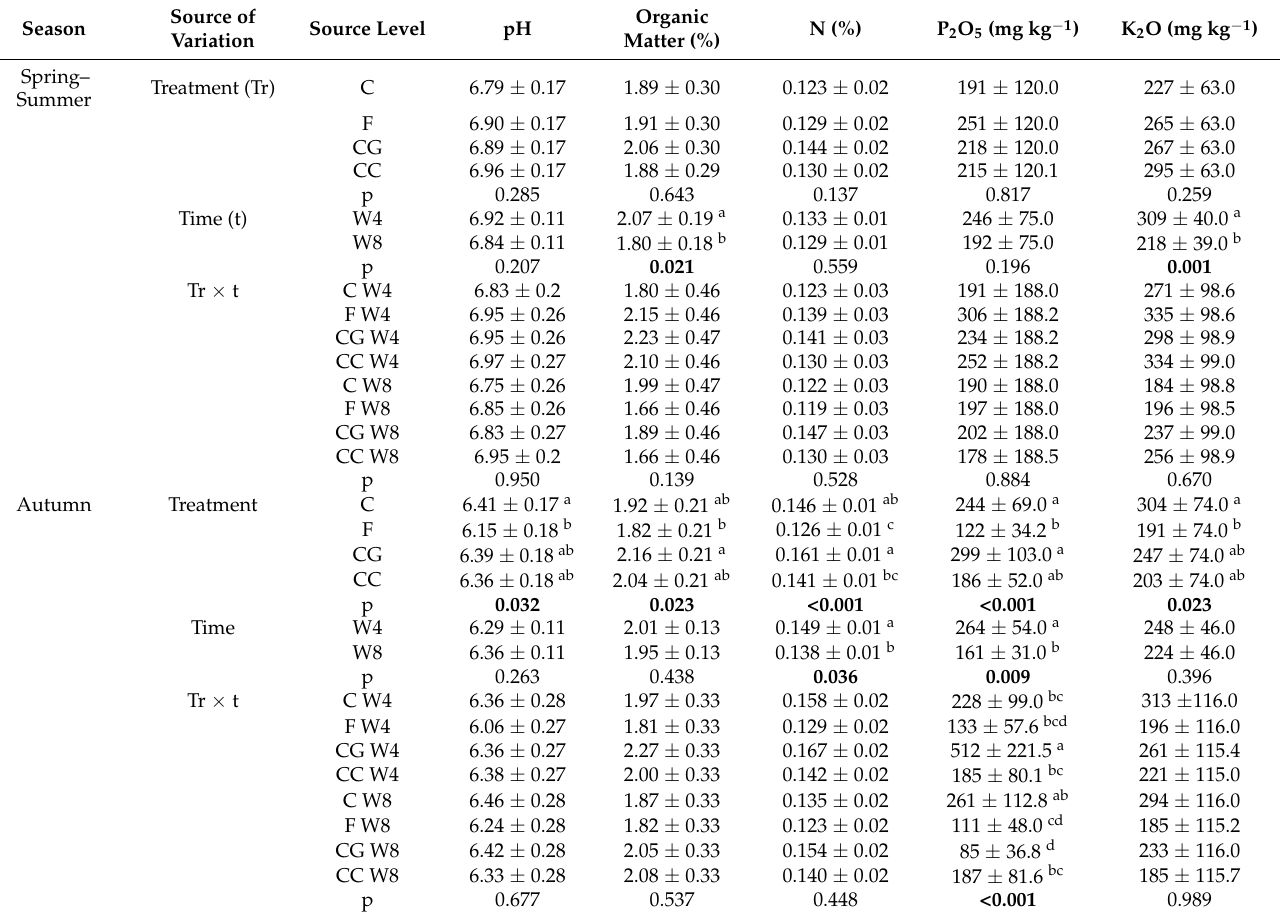
Table 4. Effect of treatment (different waste), time (sampling week), and the interaction between them on soil properties from soils collected in the experimental field plots during Experiment 3 (Spring–Summer, 2020) and Experiment 4 (Autumn, 2020). Least-square mean values ( ± confidence intervals) are shown. n =